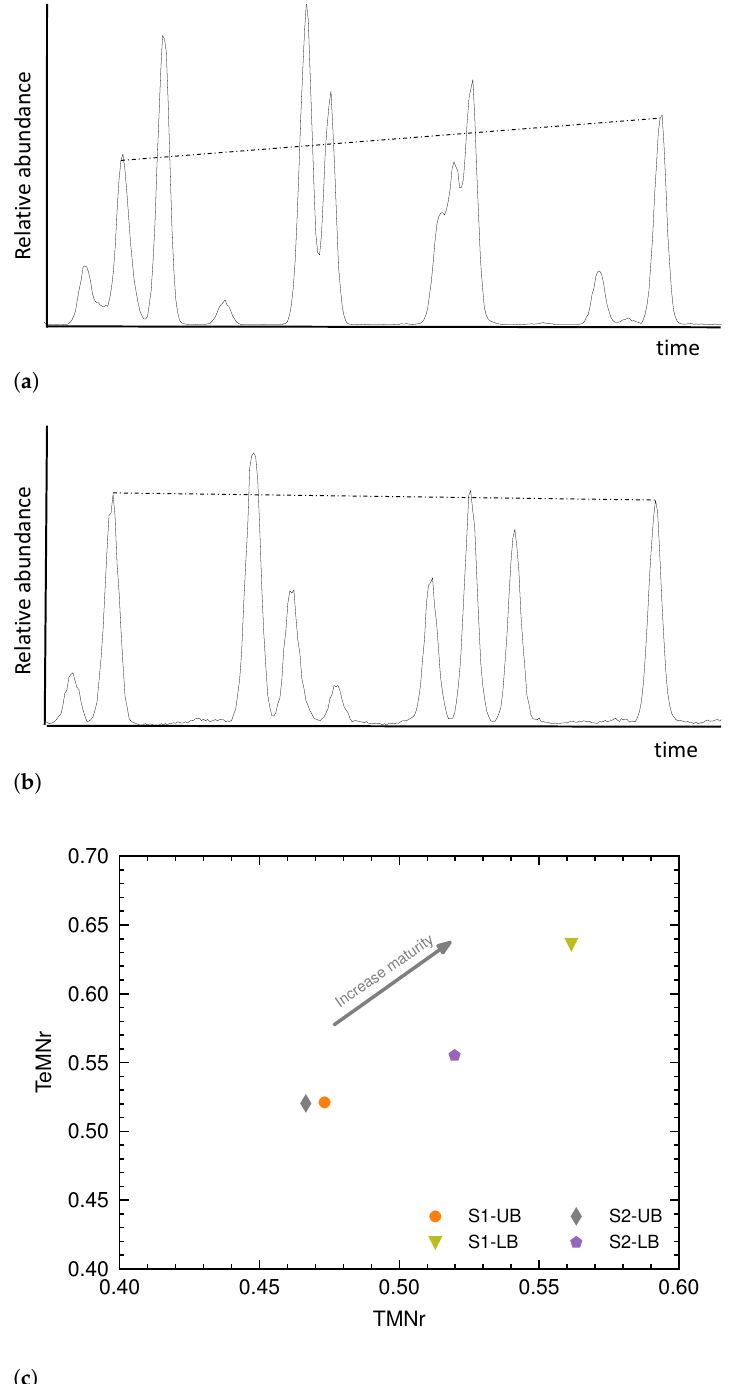
Figure 9. The relative distribution of ( a ) trimethylnaphthalenes, ( b ) tetramethylnaphthalenes, and ( c ) their correlation: TMNr, (1,3,7-trimethylnaphthalene)/(1,3,7 + 1,2,5 -trimethylnaphthalene); TeMNr, 1,3,6,7-tetramethylnaphthalene/(1,3,6,7 + 1,2,5,6 + 1,2,3,5